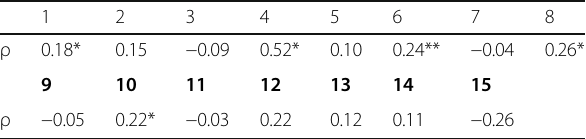
Table 5 Spearman ’ s Rank Correlation Between Different